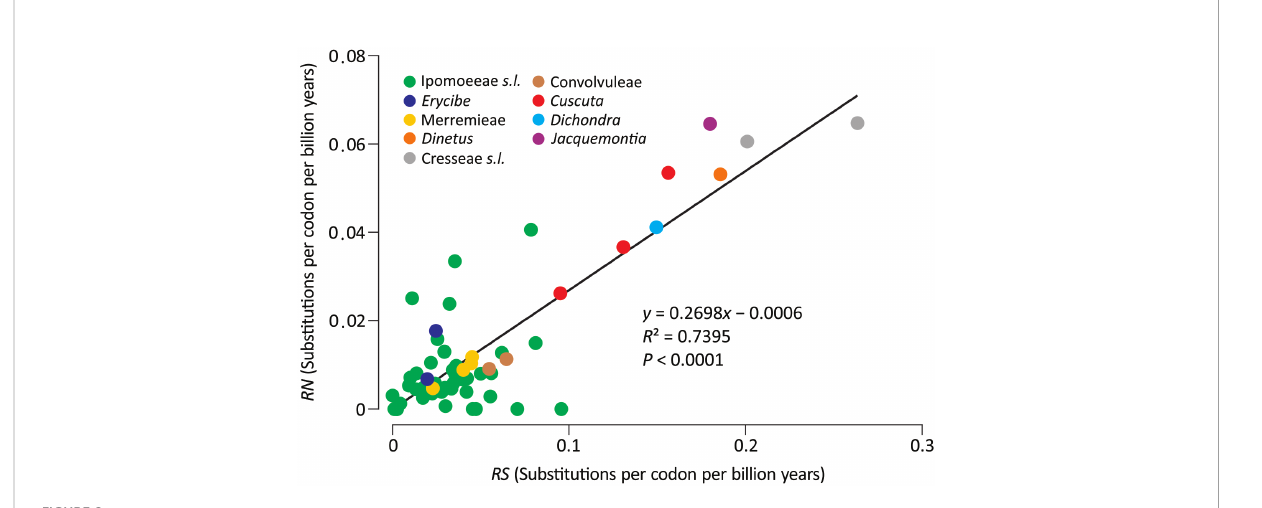
FIGURE 2 Comparisons of absolute synonymous ( RS ) versus nonsynonymous ( RN ) substitution rates across Convolvulaceae. The solid line is the regression between RN and RS